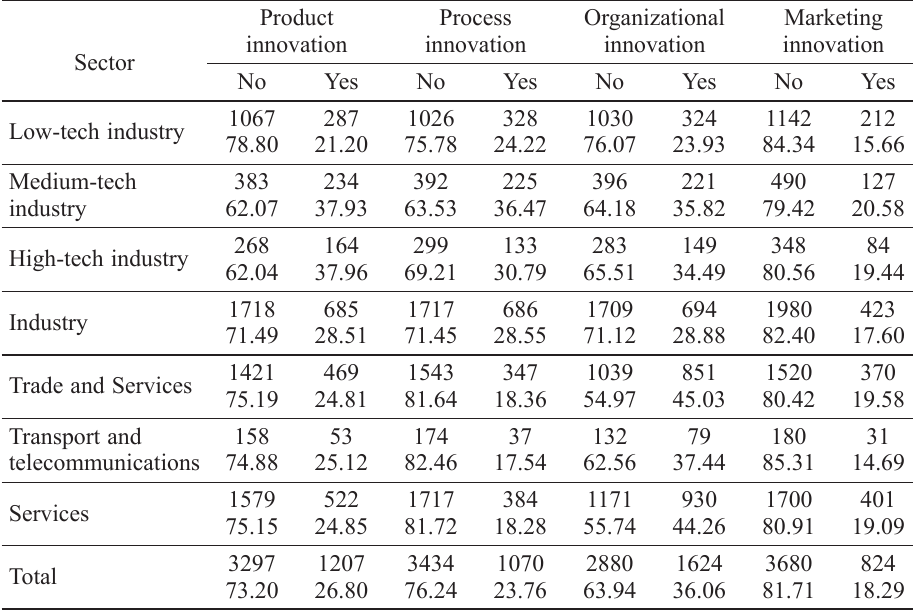
Table 1. Two-way table of absolute and relative frequencies Product innovation Sector